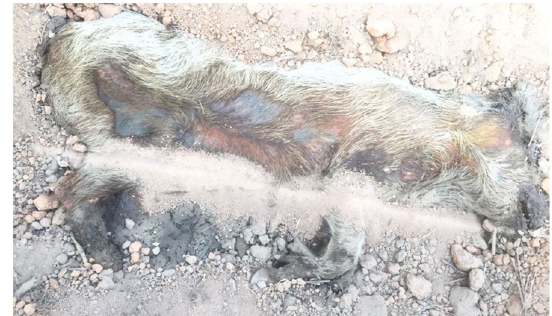
Fig. 4 Day 14 — early active decay